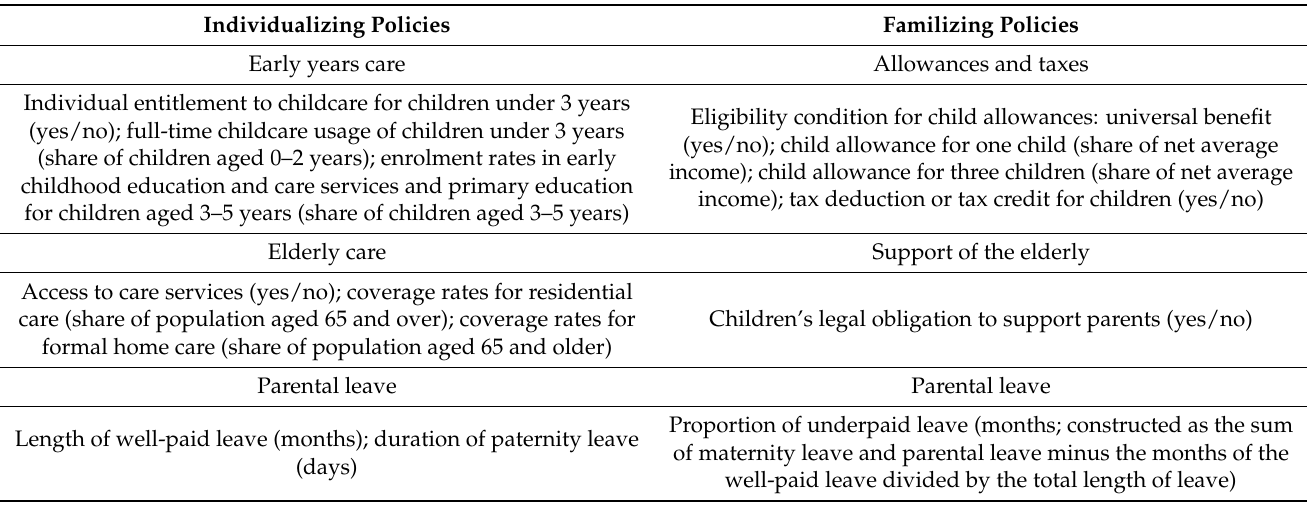
Table 2. The indicators constructing the individualizing and familizing policy indices used in the present